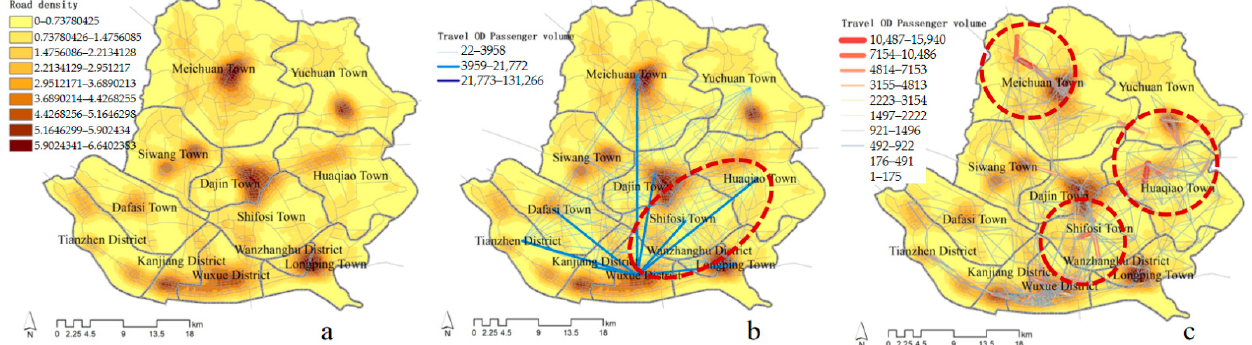
Figure 9. Analysis of road network density and travel OD passenger volume distribution. ( a ) Road network density ( b ) Administrative district level. ( c ) Township district level.